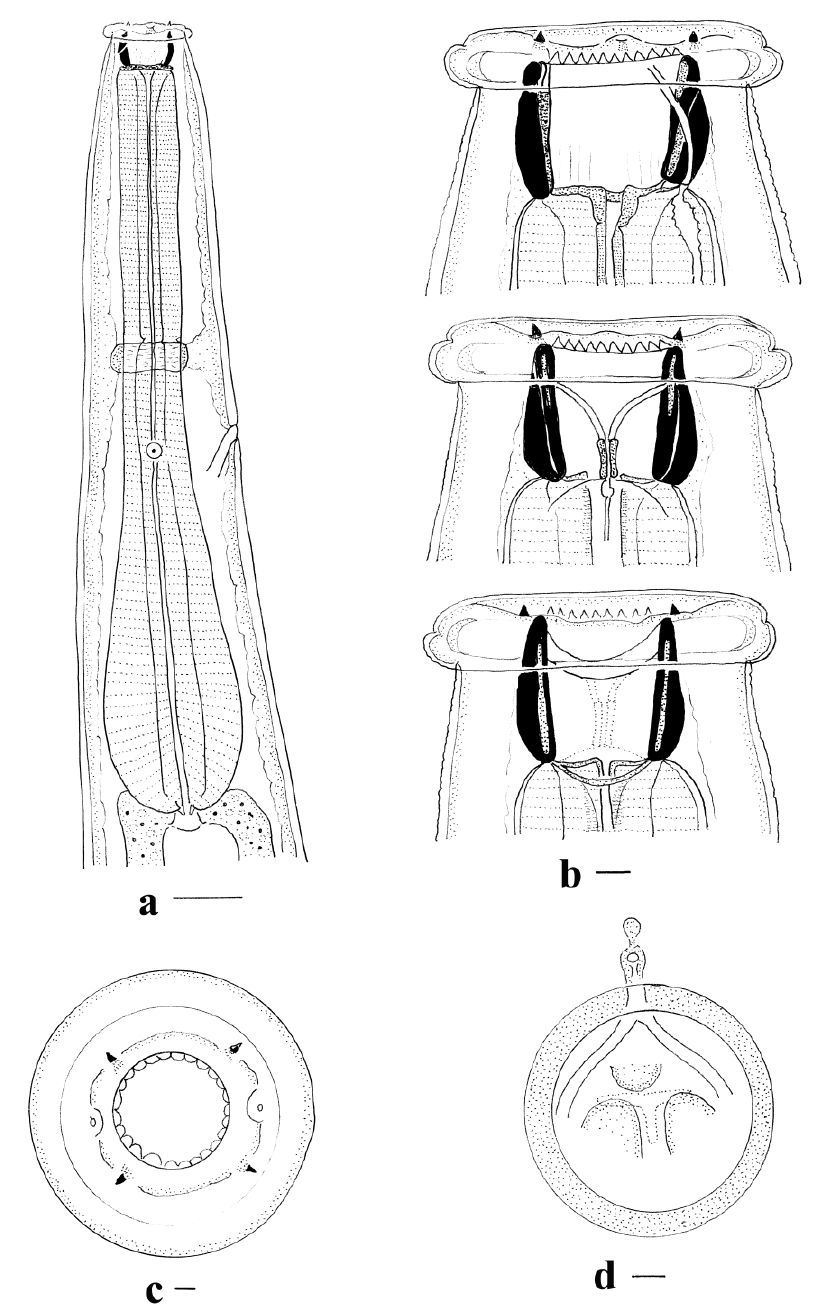
Figure 1. Torquenema toraliforme n. comb. ( a ) Anterior region, right lateral view; ( b ) Buccal capsule, dorsal and lateral views; ( c ) Anterior extremity, apical view; ( d ) Buccal capsule, optical transverse section. Scale-bars: ( a ), 0.1 mm; ( b – d ), 0.01 mm.